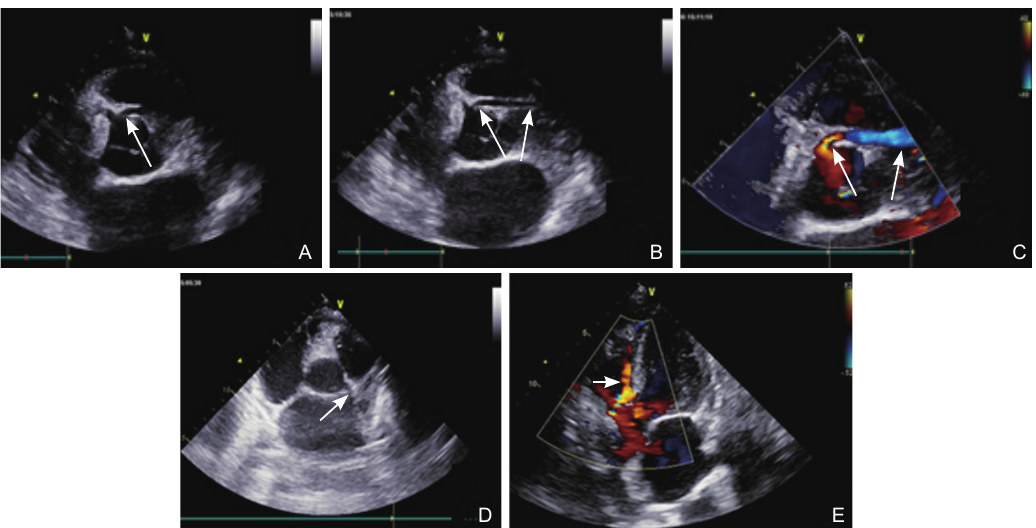
Figure 1 Transthoracic echocardiography from a short-axis plane in a patient with anomalous origin of the left coronary artery from the right sinus of Valsalva. (A) The parasternal short-axis view showed two vessels, one being an RCA and the other being an ectopic left main coronary artery from the right coronary sinus that the shape likes the seagull. The single coronary orifice arising from the right aortic sinus is visualized (arrow) with bifurcation into the right and left coronary arteries. The beginning of the left coronary artery is at an acute angle to the aortic wall; (B) The anomalous left coronary artery can be seen coursing between the aortic and pulmonary roots and extended to the left anterior descending branches (arrows); (C) Color Doppler image shows that the red stream of blood flowing from the right coronary sinus, gradually turns blue; (D) The arrow indicates the site of the left circumflex branch originates from the left coronary sinus; (E) the arrow shows a bright red flow along the interventricular septum in a nonstandard five-chamber view of the apical